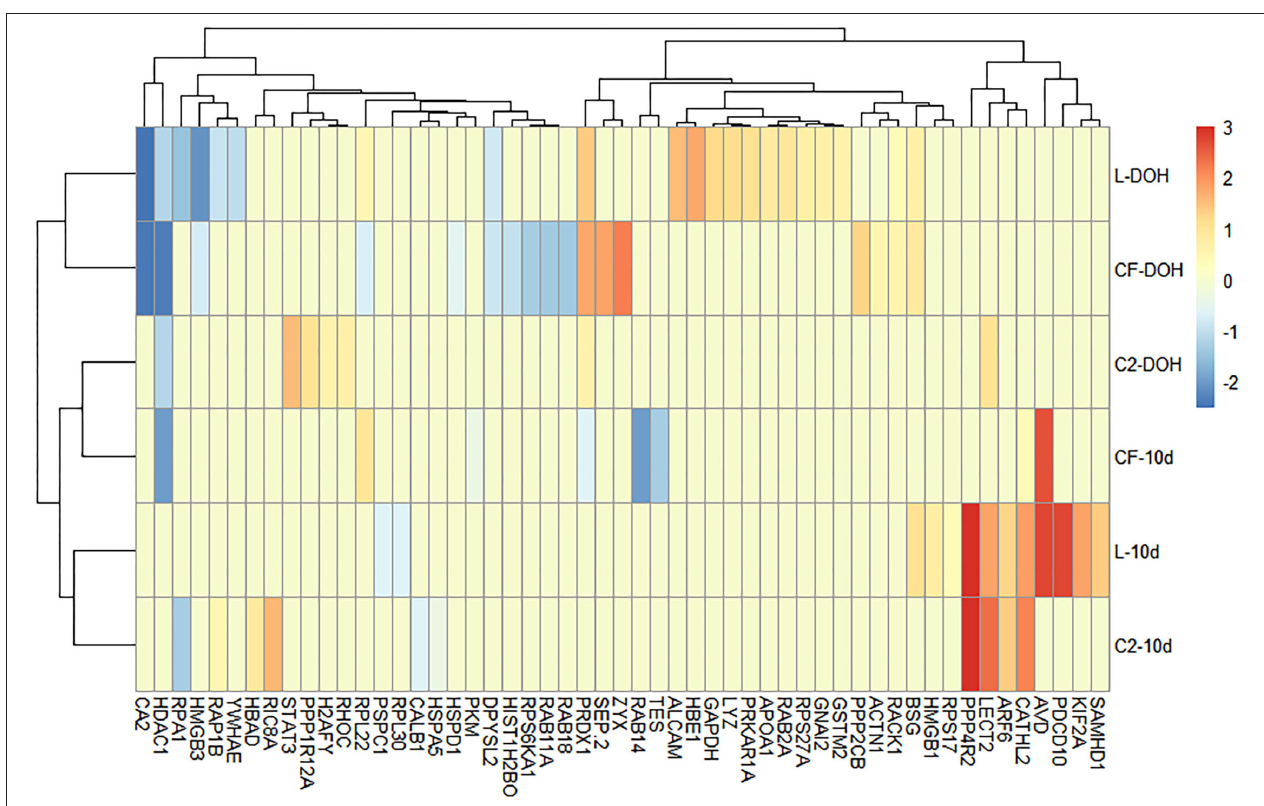
FIGURE 1 | Differentially expressed proteins (DEPs) related to immune processes based on Gene Ontology analysis. Heatmap plot represents the log2-fold changes of proteins expressed intestine samples of broilers treated with lactic acid bacteria (L), Citrobacter freundii (CF) or Citrobacter spp. (C2) in relation to control treatment at the day of the hatch (DOH) and 10 days of age (10d). Blue shades represent downregulation, while red shades indicate upregulation of the particular protein. Light yellow cells indicate no